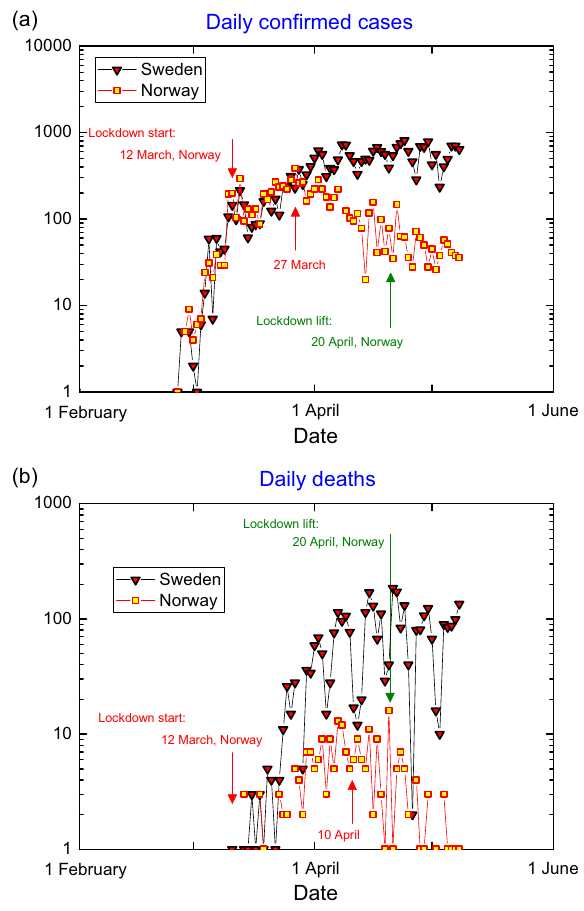
Figure 3. Comparison of daily (a) con fi rmed cases and (b) deaths in Sweden and Norway [36,